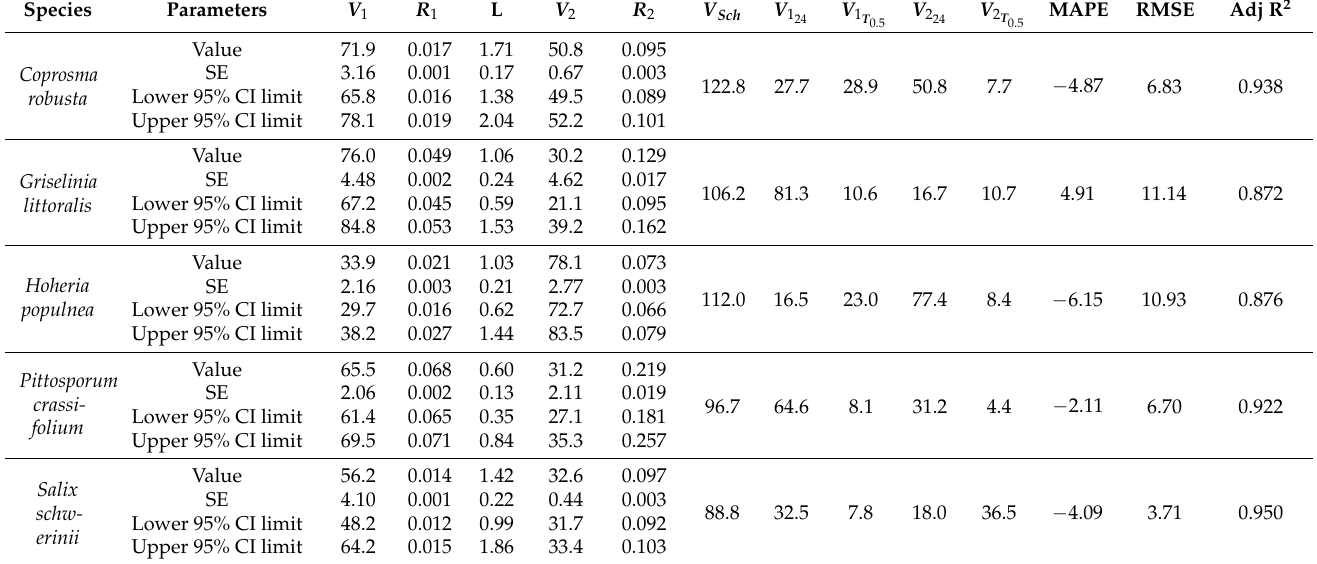
Table 8. Native ( Coprosma robusta, Griselinia littoralis, Hoheria populnea , and Pittosporum crassifolium ) and exotic ( Salix schwerinii ) shrub species leaf in vitro fermentation kinetic parameters derived using dual pool model, where, L, lag time (h); V 1 , fast-pool total gas production (mL/g DM); V 2 , slow pool (mL/g DM); R 1 , fast-pool rate of gas production (%/h); R 2 , slow rate (%/h); V Sch , total gas production (mL/g DM); V 1 , total gas production for the fast pool after 24 h (mL/g DM); V 2 24 pool after 24 h (mL/g DM); V 1 , fast-pool total-gas-production half-life (h); and V 2 T 0.5 half-life